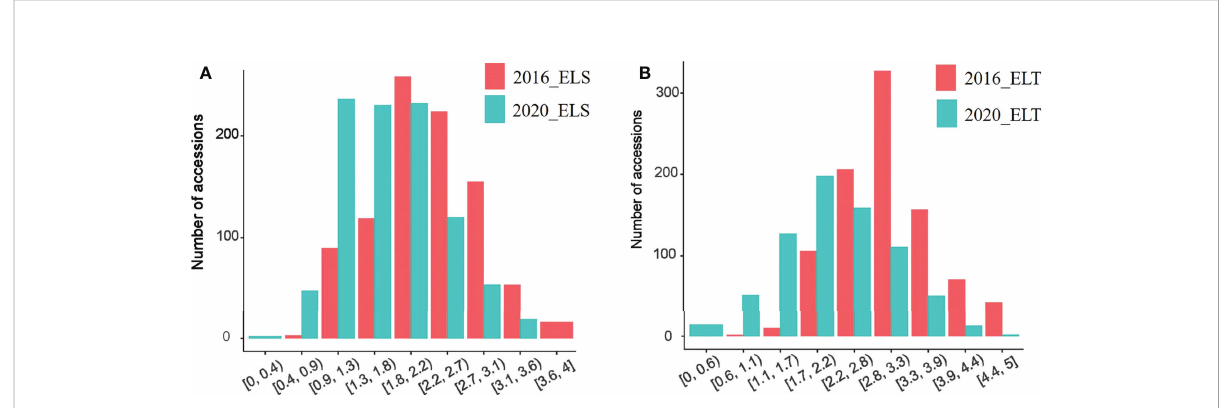
FIGURE 5 ELS and ELT phenotype distriution. (A) ELS phenotypes at different ages (B) ELT phenotypes at different